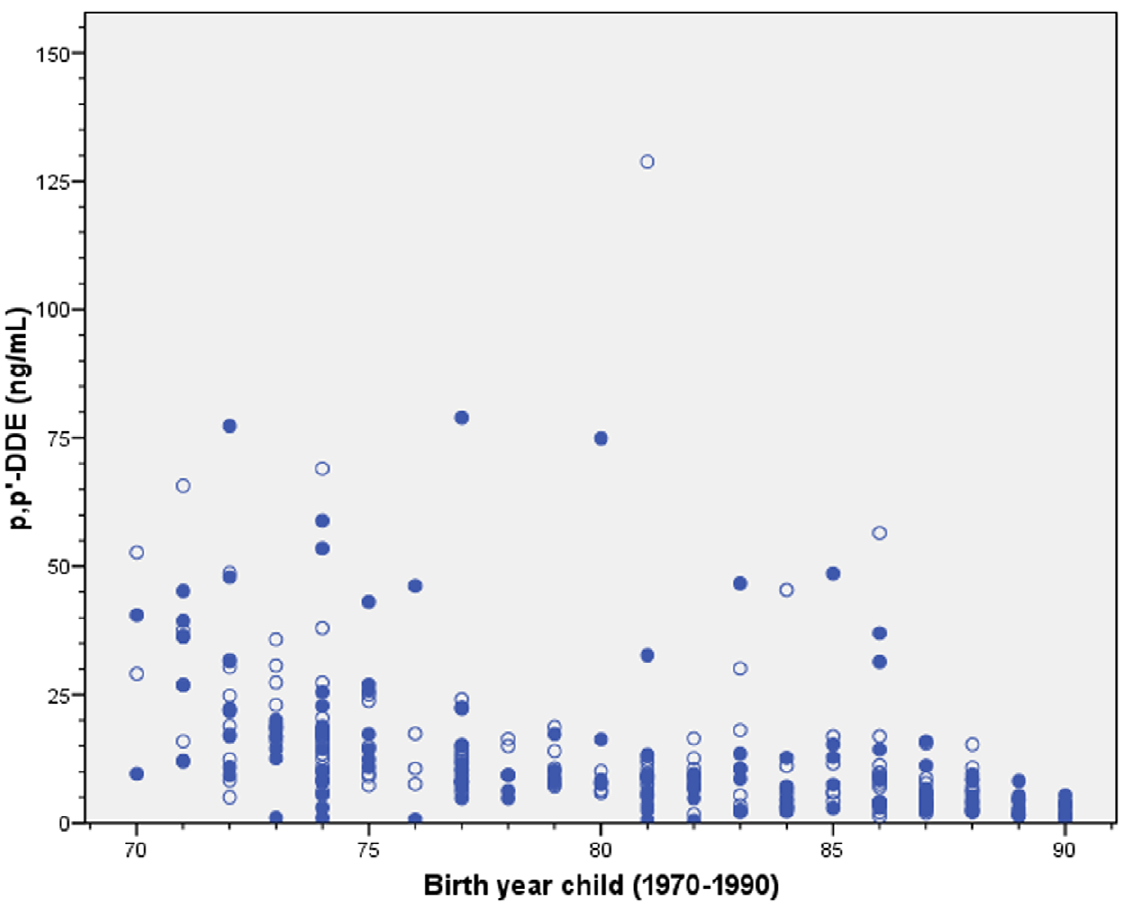
Figure 2. The median maternal serum concentrations of p,p 9 -DDE from 1970–1990.